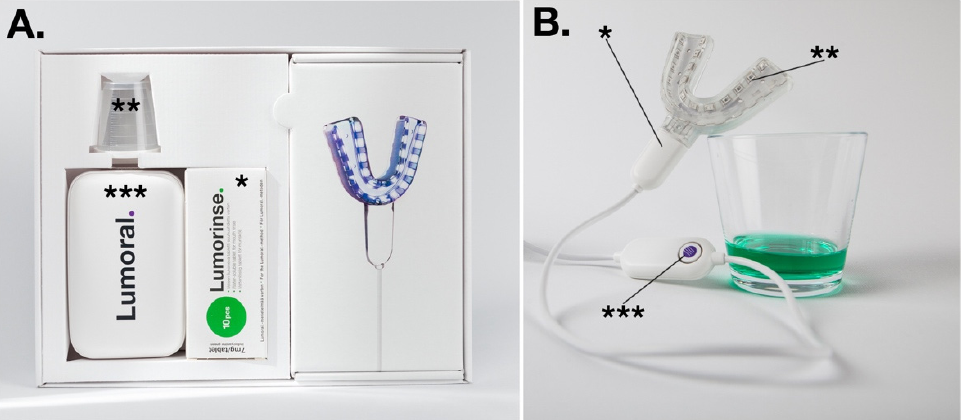
Figure 1. The dual-light aPDT device. ( A ) The packaging includes the effervescent ICG tablets (*) to be dissolved in 30 mL of water, for which a measuring cup (**) is available. A power source (***) provides electricity for the mouthguard-type light applicator. ( B ) The mouthpiece (*) is composed of 48 LED components (**) able to provide simultaneous 405 nm and 810 nm light. Symmetrically assembled LEDs provided light for both maxillary and mandibular dental arch. The button on the control unit provided a treatment time of 10 min (***). The glass contains dissolved mouth rinse.